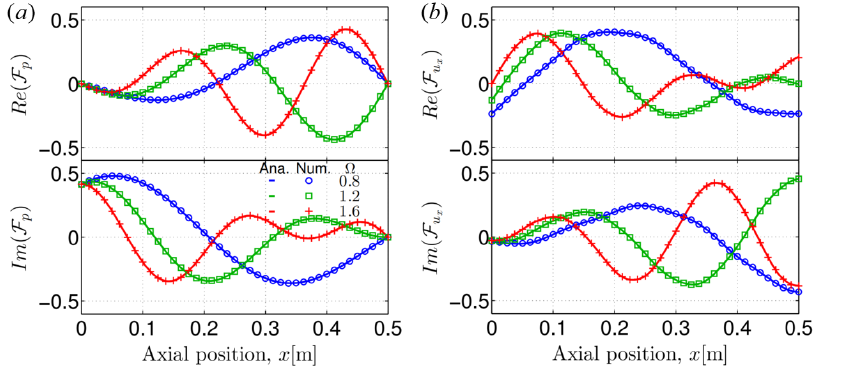
Figure 3. 1T mode: variations of ( a ) pressure F p and ( b ) axial velocity F u axial positions. ( r , θ ) = ( r 0 /2, π /2 ) , M x ,1 =